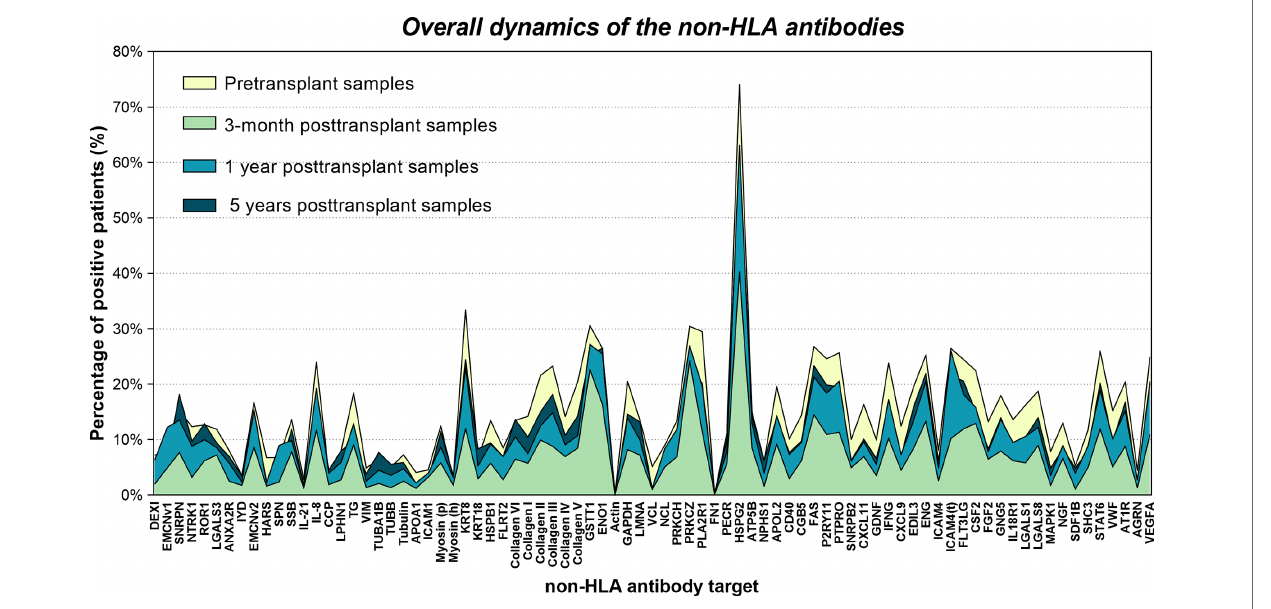
FIGURE 6 | Kinetics of the non-HLA antibodies over time. The graph shows the percentage of positive patients at the day of transplantation (pretransplant), at 3 months, 1 year and 5 years after